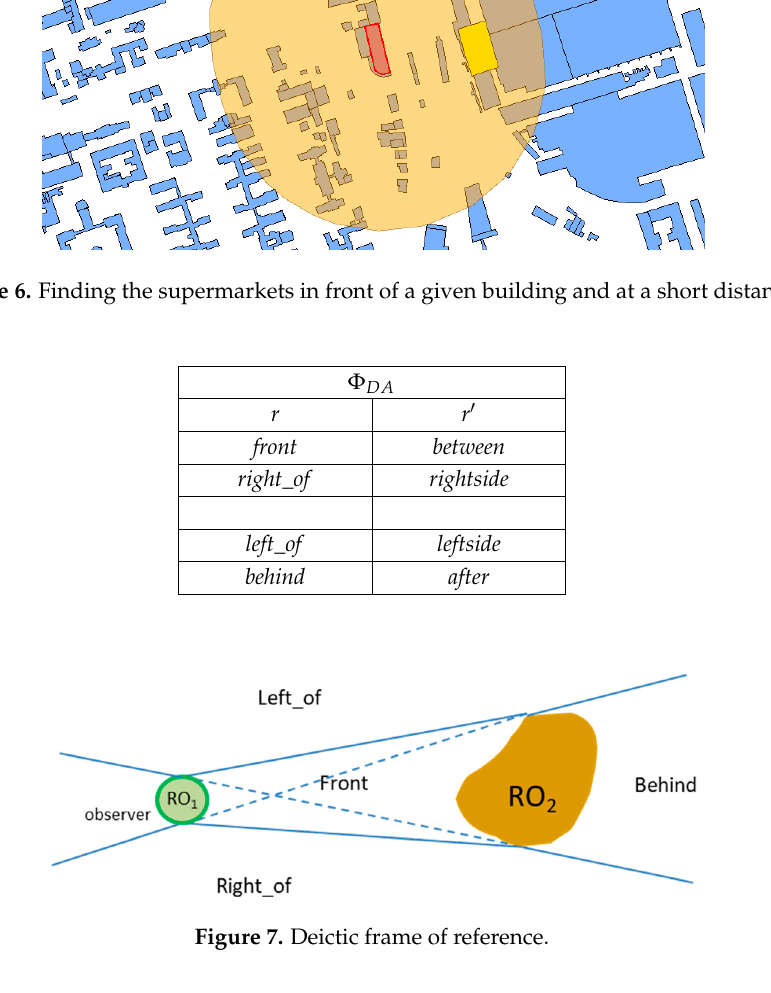
Figure 8. Finding buildings on the left side of the monument from the observer point of view.